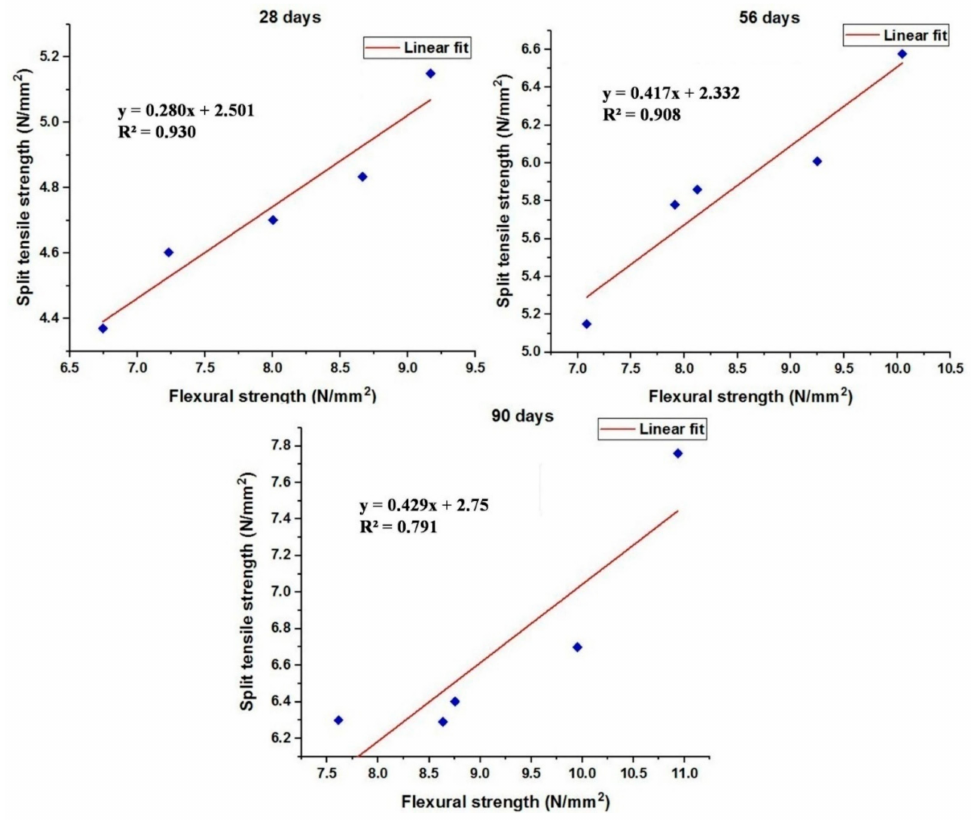
Figure 17. Relation between flexural strength and split tensile strength of the concrete mixes at various